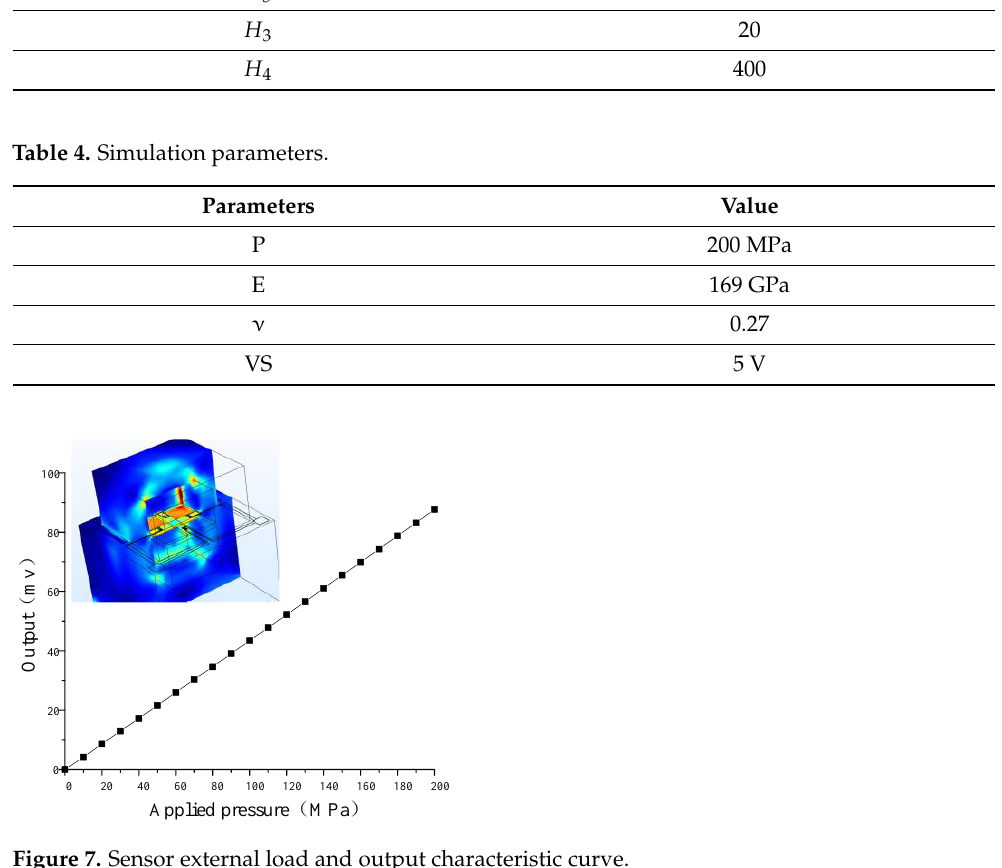
Figure 7. Sensor external load and output characteristic curve .